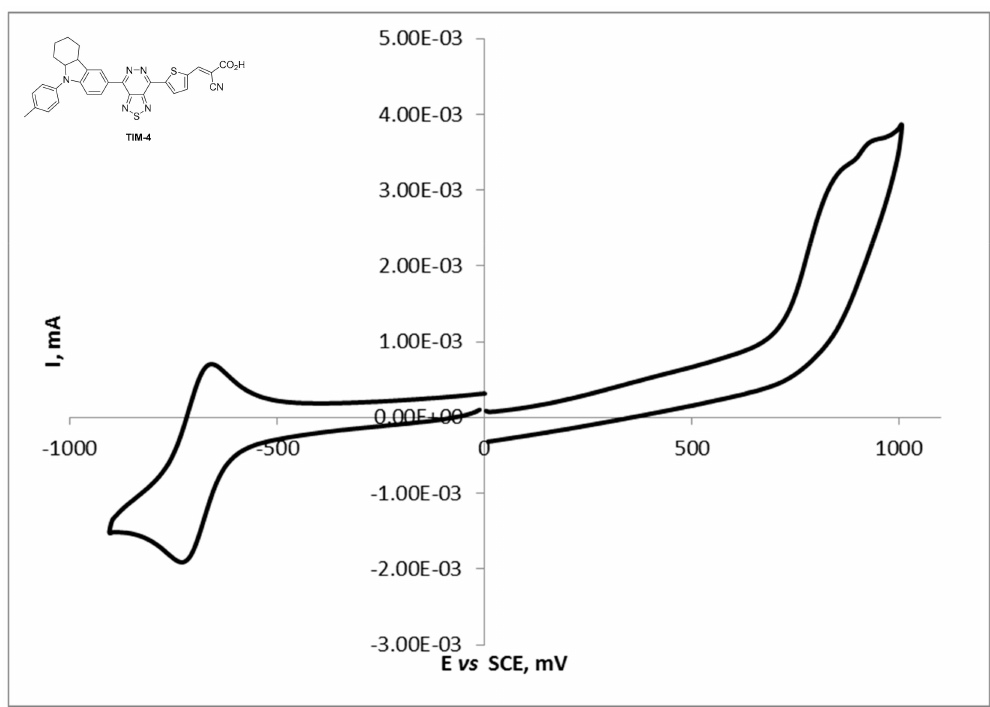
Figure 4. Cyclic voltammograms showing reduction and oxidation of TIM1 – 4 . Scan rate 100 mVs − 1 , electrolyte 0.1 M Bu 4 NClO 4 in